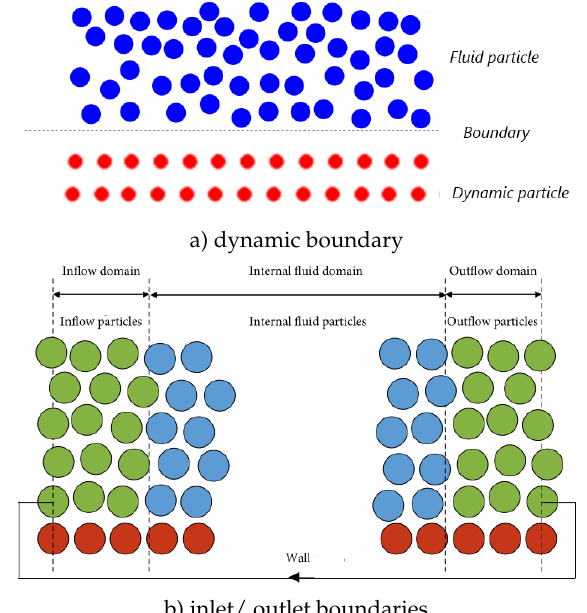
Fig. 3. Fluid – solid structure boundary